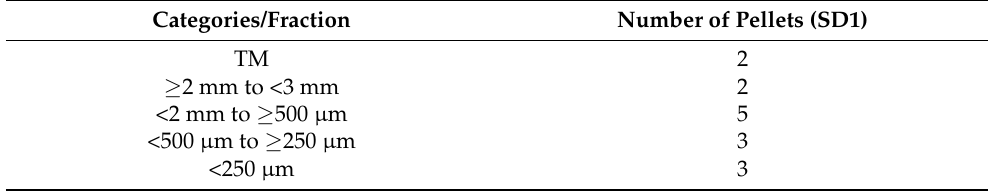
Table 1. Number of pellets by category.